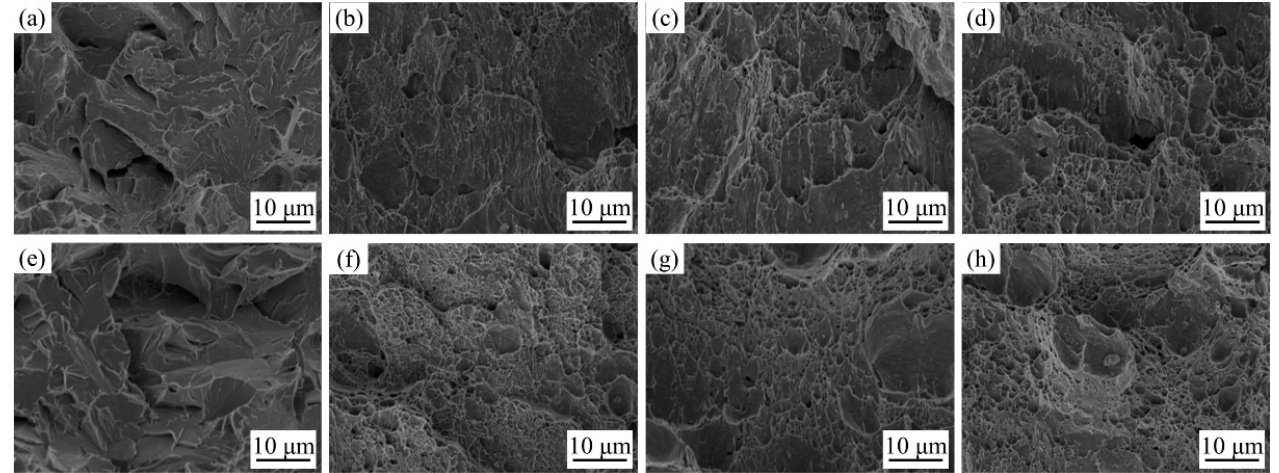
Figure 9. Microscopic morphology of impact fracture under different tempering temperatures. ( a ) 0.004ZrB, ( b ) 0.004ZrC, ( c ) 0.004ZrD, ( d ) 0.004ZrE, ( e ) 0.004ZrF, ( f ) 0.004ZrG, ( g ) 0.004ZrH, and ( h ) 0.004ZrI.